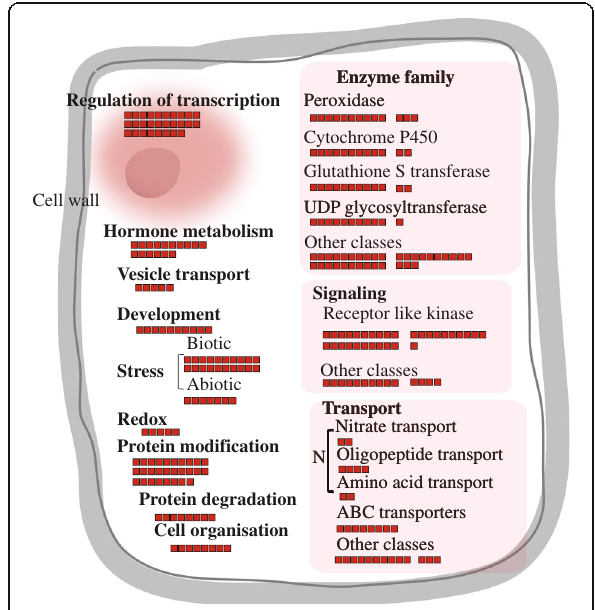
Fig. 3 MapMan analysis of root hair-preferentially expressed genes. Cell Function overview analyzed with 409 genes. Enzyme family (81 genes), signaling transduction (45), and transport (29) were most abundant, as shown with red boxes. Small boxes in overview indicate root hair-specific genes. For enzyme families, peroxidases (13 genes), cytochrome P450 (12), glutathione S transferase (12), UDP glycosyltransferases (11), and other classes (33) were identified. Among 45 genes involved in signaling function, 31 loci encode receptor-like kinases and 14 are in other classes. For transport, 8 genes encode ABC transporters; 8 are involved in uptake of nitrogen sources such as nitrate, peptides, and amino acids; and 13 are